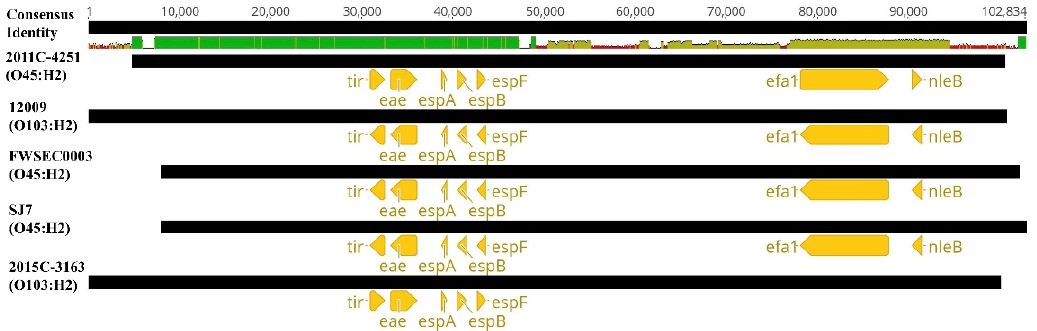
Figure 4. Maximum likelihood phylogenetic analysis based on the MAFFT algorithm of the Stx prophages from the genomes of six STEC O45 strains and two STEC O103:H2 strains. The phylogenetic tree indicates three distinct clusters among the Stx prophages, in orange for cluster 1, navy for cluster 2, and red for cluster 3. Stx prophages highlighted in purple and light blue indicates they were obtained from the bacterial strains sequenced in this study. All Stx prophage sequences in the bacterial chromosome were predicted using the PHASTER web server. Figure 5. Nucleotide sequence alignments of the locus of enterocyte effacement (LEE) pathogenicity islands from the genomes of three clinical STEC O45:H2 strains (SJ7 (sequenced in this study), FWSEC003, and 2011C-4251), and two clinical STEC O103:H2 strains (12009 and 2015C-3163) using the MAFFT algorithm. The consensus identity of the alignment of five LEE pathogenicity islands indicates the mean pairwise nucleotide sequence identified for all pairs in the column: green = 100% identity; green-brown = <100% but >30% identity; and red = <30% identity. Virulence genes within the sequence of each LEE pathogenicity island (black ) are annotated and colored ( yellow ).